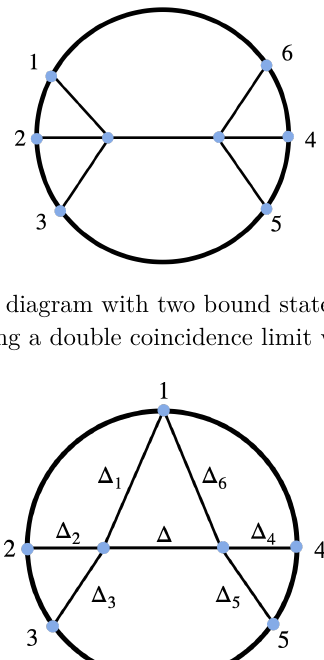
Figure 11 . A five-point Witten diagram with one bound